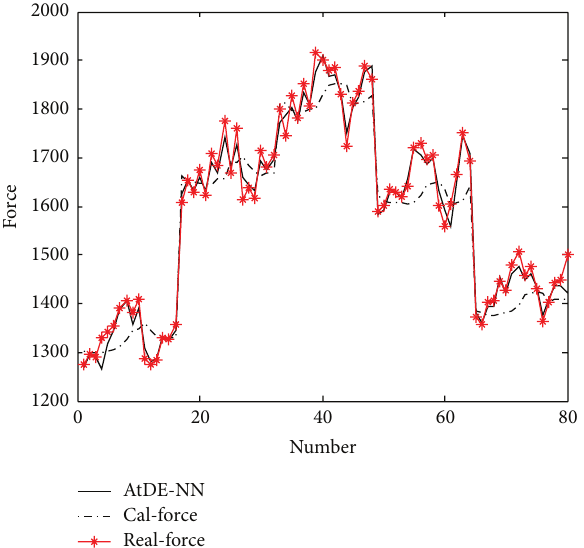
Figure 6: Comparison between AtDE neural network model and the conventional model of rolling force prediction value and the measured